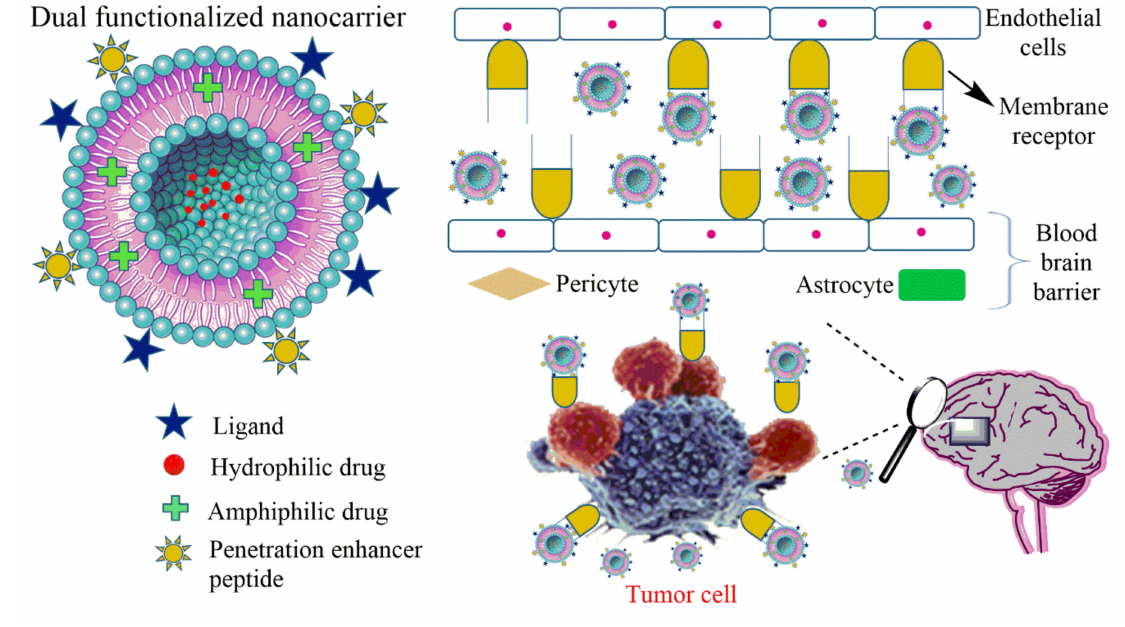
Figure 3. Schematic display of dual-functionalized nanocarrier-based therapeutic system for brain